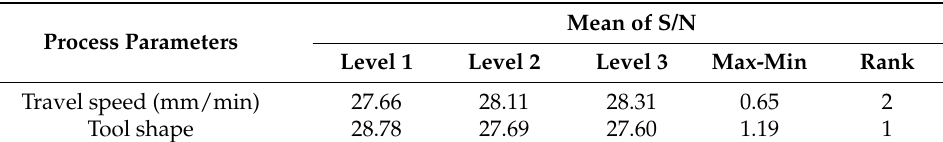
Table 7. Mean S/N ratio response table for hardness.